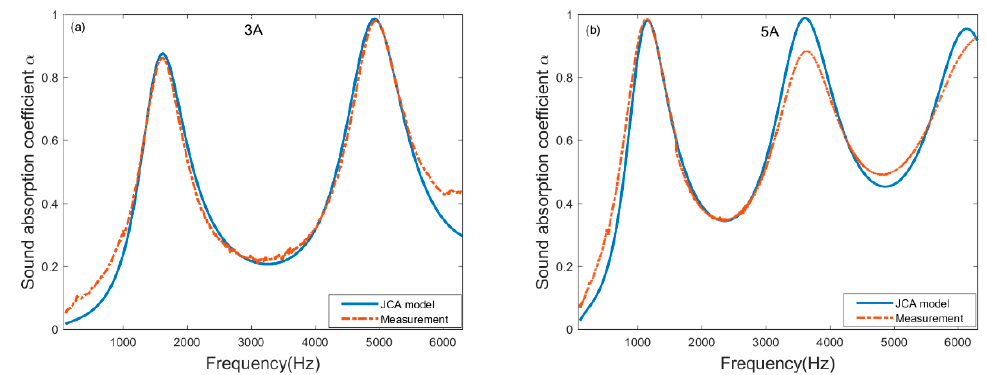
Figure 5. Comparison between measurement by impedance tube and estimation through inversion of JCA model. ( a ) 3Å molecular sieve pellets with thickness of 40 mm; ( b ) 5Å molecular sieve pellets with thickness of 50 mm.